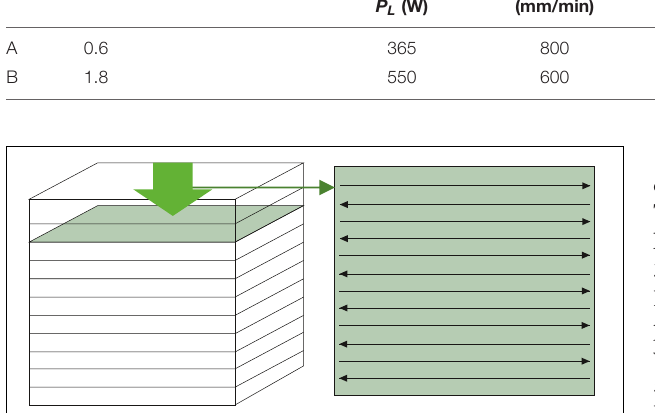
FIGURE 1 | Schematic diagram of bidirectional track deposition pattern in laser material deposition (LMD).